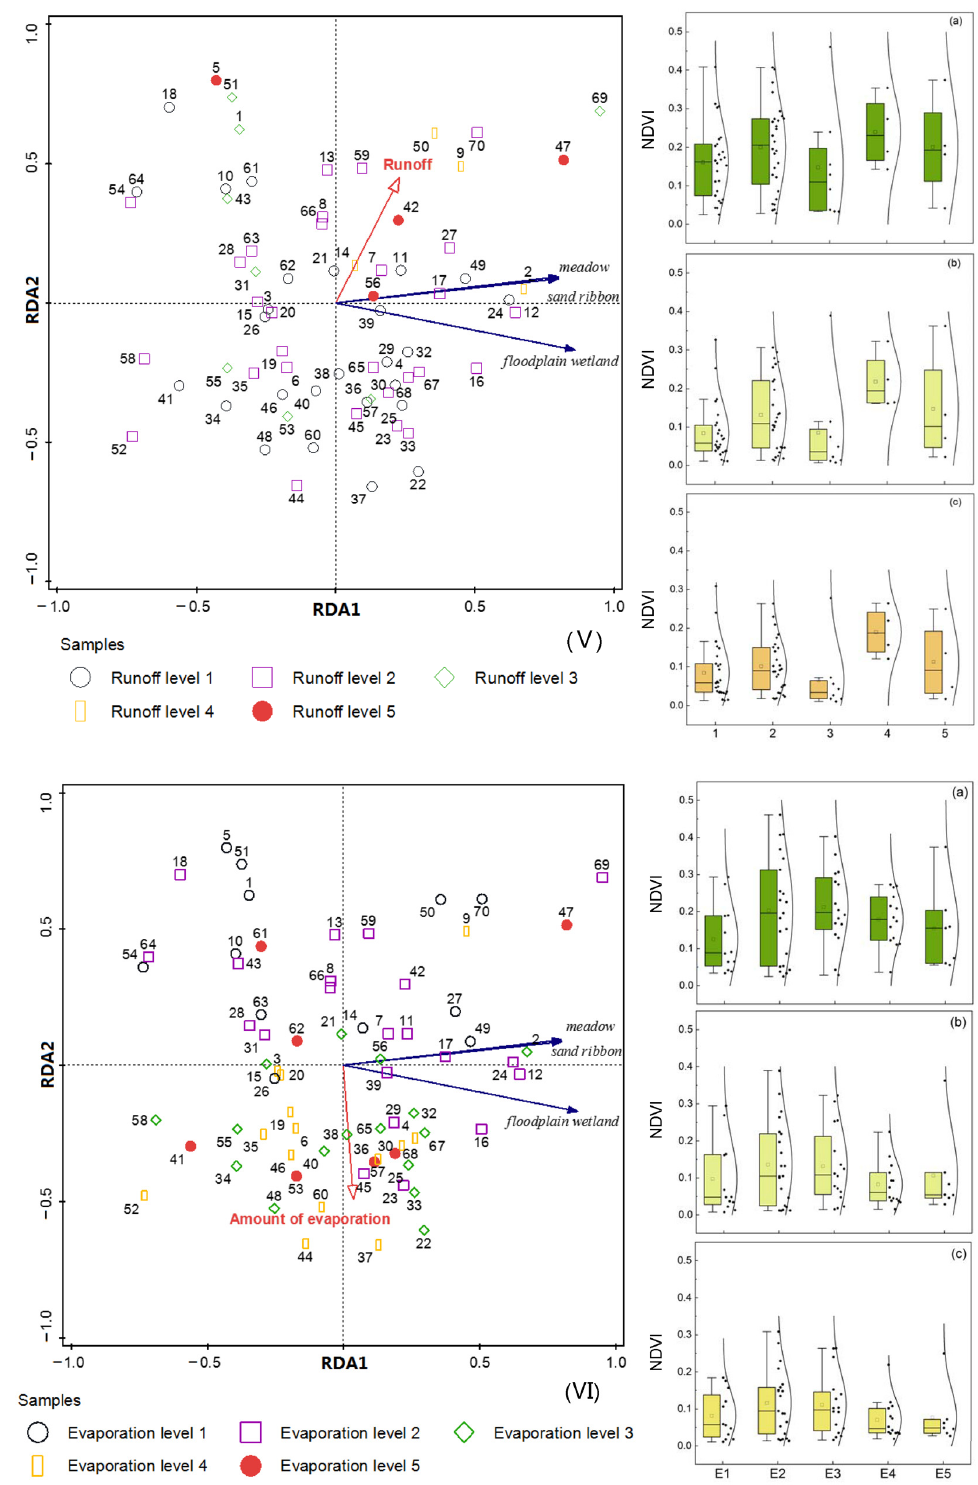
Figure 7. Driving factors grouping characteristics and data statistical graph. ( I ) is the phenological period characteristic, ( II ) is the humidity characteristic, ( III ) is the temperature characteristic, ( IV ) is the precipitation characteristic, ( V ) is the runoff characteristic, and ( VI ) is the evaporation charac- teristic. ( a ) is the statistical distribution of floodplain wetland, ( b ) is the statistical distribution of meadow, and ( c ) is the statistical distribution of sand ribbon. The horizontal line in the boxplot is the median, and the hollow point is the mean. The black point on the right is the NDVI, and the curve is the distribution